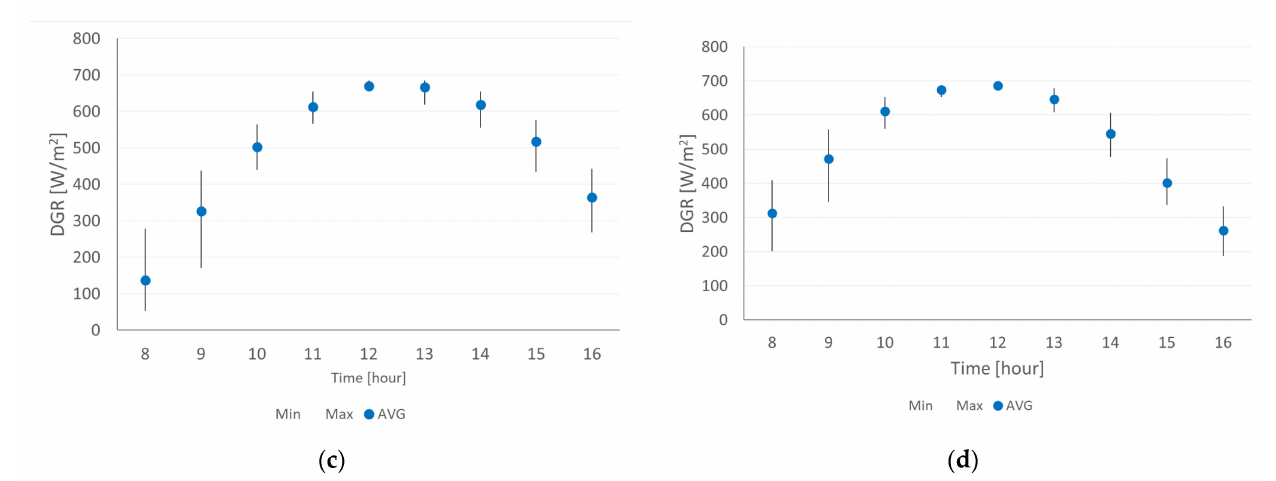
(cid:17) (cid:16) (cid:104) t (cid:105) and h , i